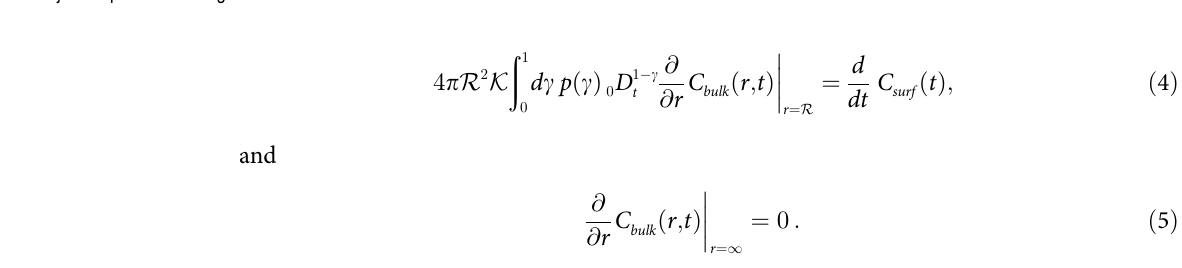
Fig 1. Release process. Illustration of the capsaicinoids releasing process from the surface of PCL microparticles to bulk.